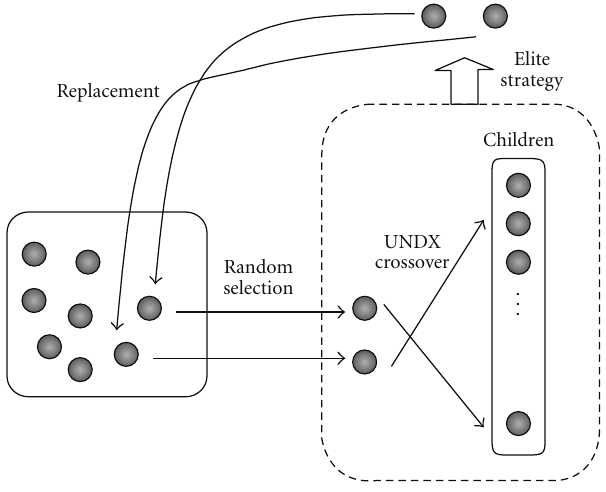
Figure 1: Schemes for generation